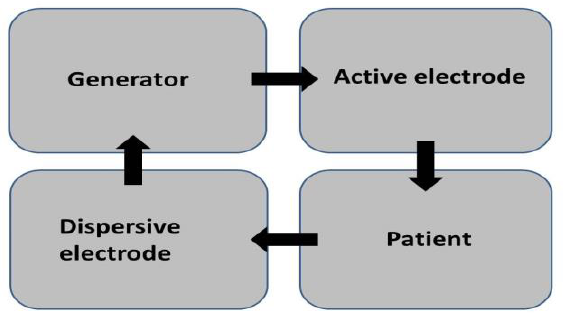
Figure 4: Circuit of a monopolar electrosurgical system.